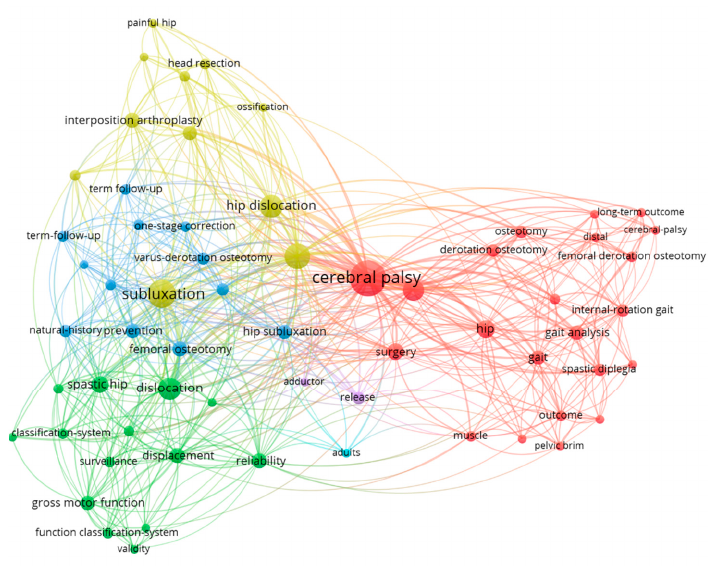
Figure 5. Bibliographic coupling by authors.